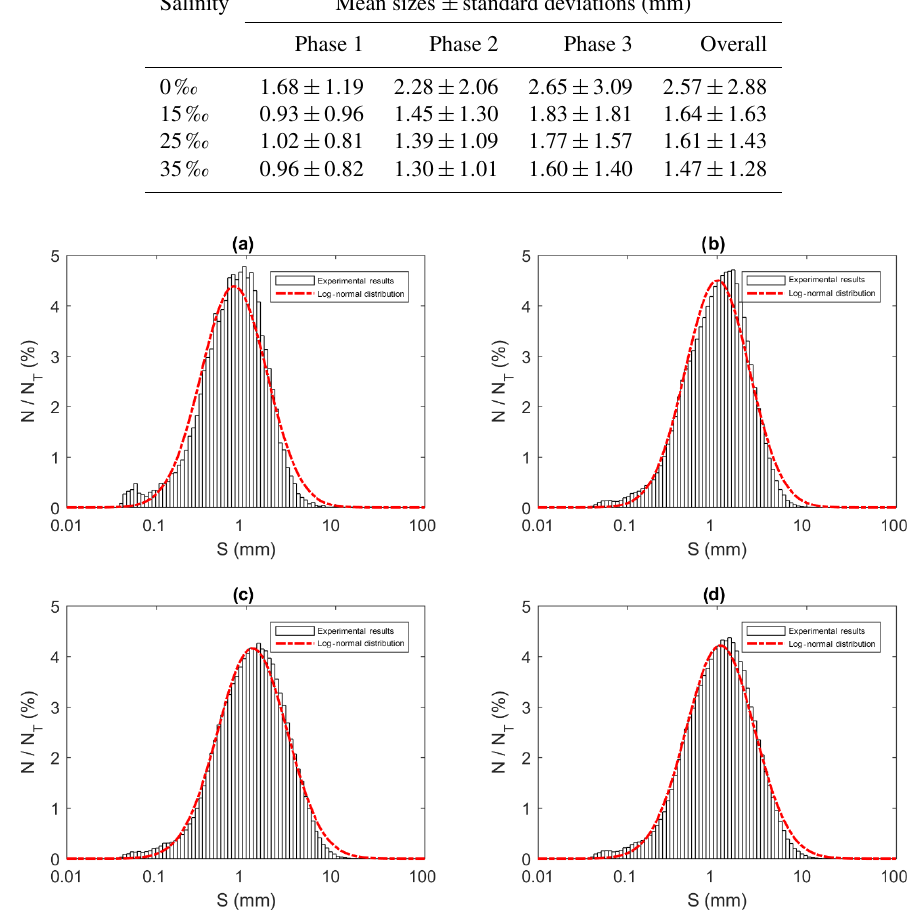
Figure 14. Size distributions of flocs at a salinity of 35‰ during (a) Phase 1, (b) Phase 2, (c) Phase 3 and (d) the entire time interval (i.e. averaged over all three phases). N is the number of flocs in each bin, N T is the total number of flocs ( N T ≈ 23880, 136950, 270790 and 431620 in a , b , c and d , respectively) and S is the floc size (mm). Note that the arithmetic mean of flocs sizes were 0.96, 1.30, 1.60 and 1.47mm for (a) , (b) , (c) and (d) ,